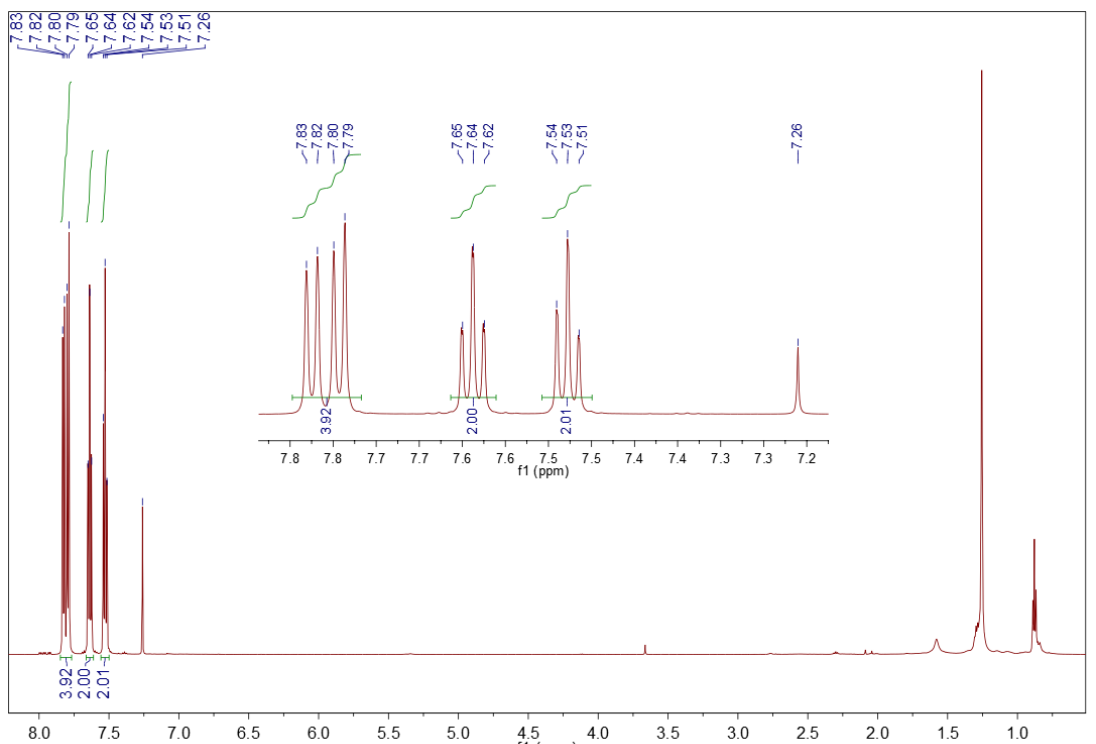
Figure 9. 1 H NMR spectrum of sediment precipitated from the surrogate HGO. Sample of 10 mg in 0.7 mL deuterated chloroform, 600 MHz.